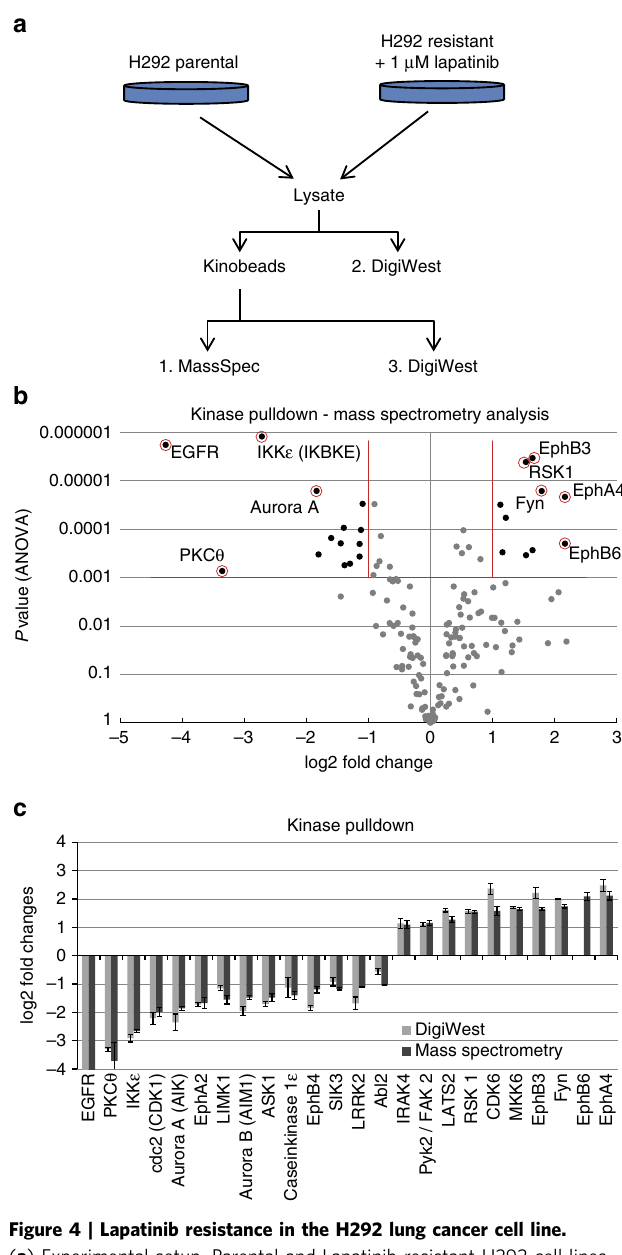
Figure 4 | Lapatinib resistance in the H292 lung cancer cell line. ( a ) Experimental setup. Parental and Lapatinib-resistant H292 cell lines were lysed, and a portion was used for Kinobead pull-down and mass spectrometry analysis, followed by analysis using DigiWest. Whole-cell lysates were analysed using DigiWest. ( b ) Volcano plot of the mass spectrometry analysis (in triplicate), log2 fold change of the Lapatinib-resistant H292 cell line compared with the parental cell line. ( c ) A set of 24 kinases displayed significant changes (ANOVA P o 0.001, fold change 4 2, peptides Z 2). This set of kinases was re-analysed using DigiWest. The Pearson’s correlation coefficient for these two methods was 0.98 (EGFR excluded). EphB6 could not be measured because no suitable antibody was